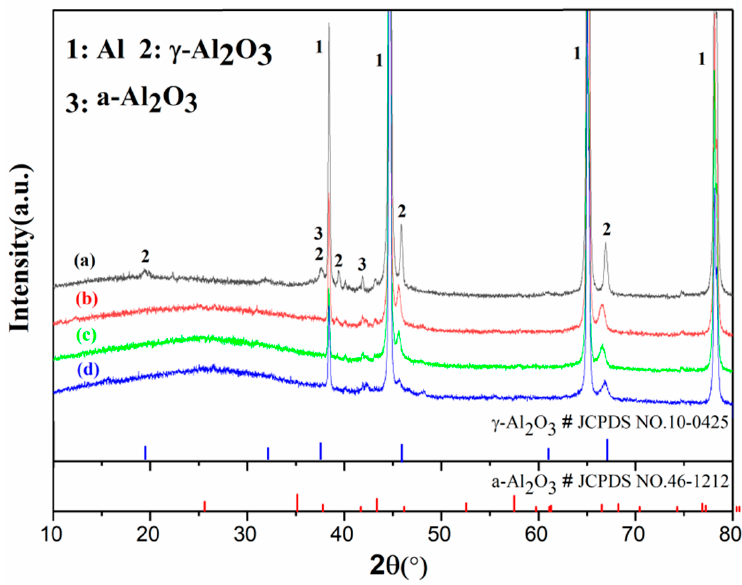
Figure 6. XRD pattern of different MAO films: ( a ) Ti0-15, ( b ) Ti5-15, ( c ) Ti5-25 and ( d ) Ti5-35.